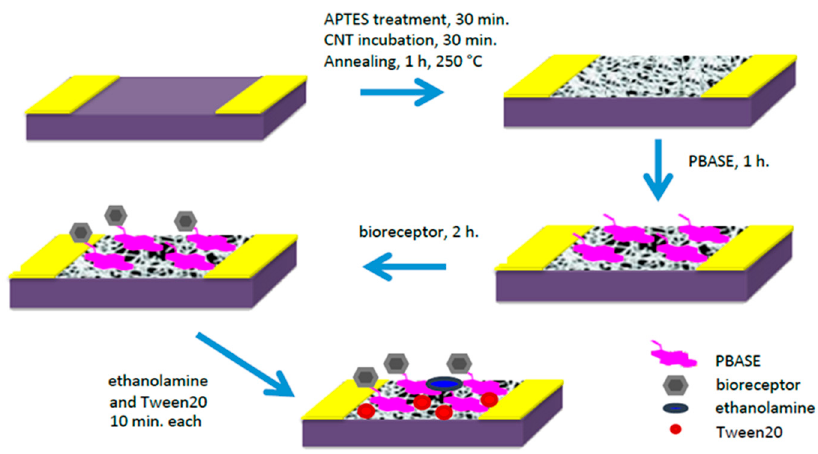
Figure 1. Device fabrication schematic. Using PBASE linker molecule, two bioreceptors can be functionalized onto the surface, amine-modified saccharides or lectin proteins.